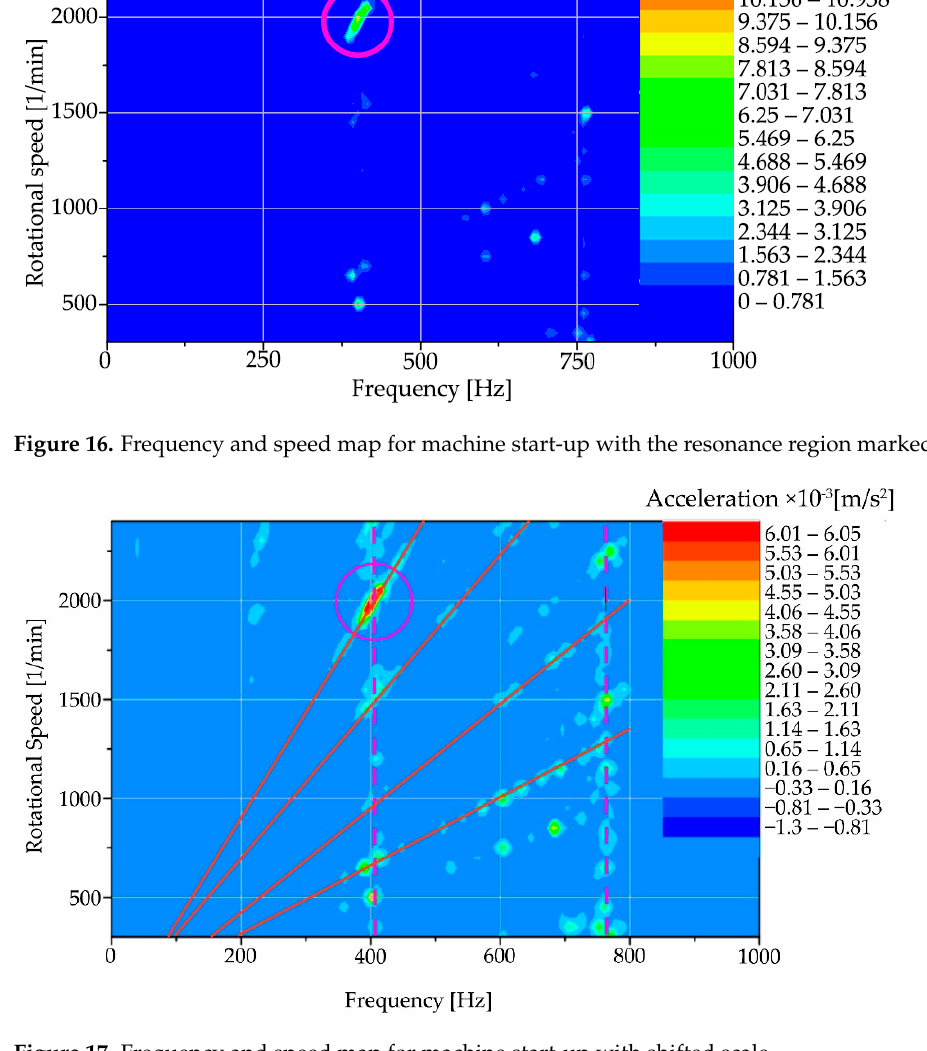
Figure 16. Frequency and speed map for machine start ‐ up with the resonance region marked.